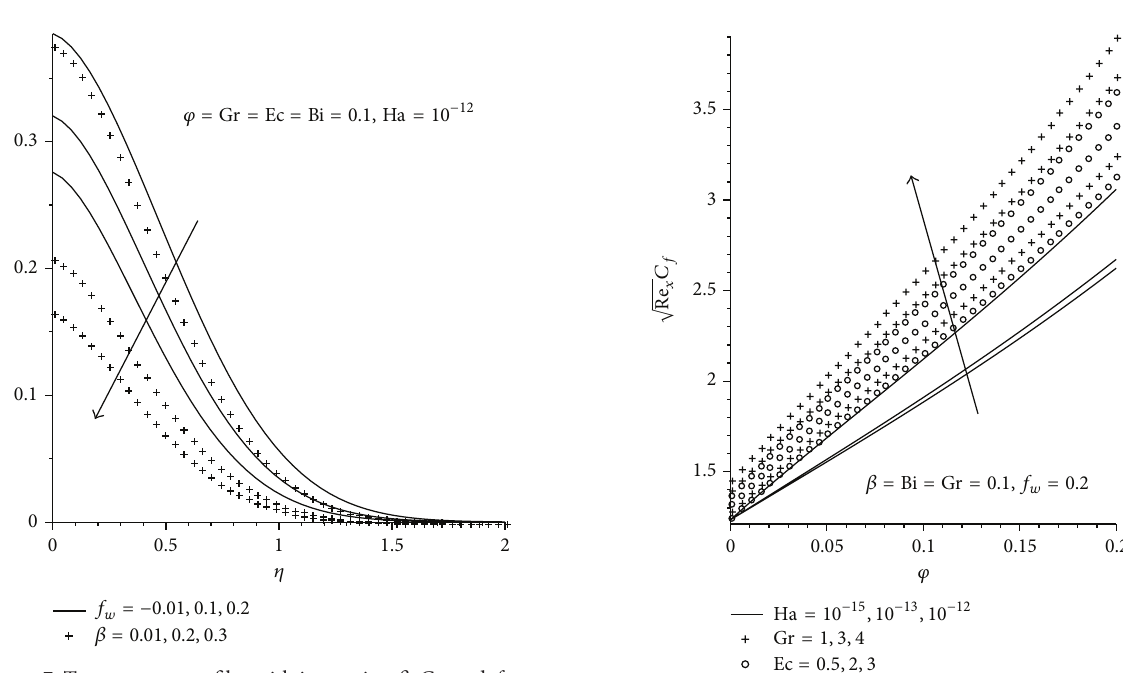
Figure 7: Temperature profiles with increasing 𝛽 , Gr, and 𝑓 𝑤 .